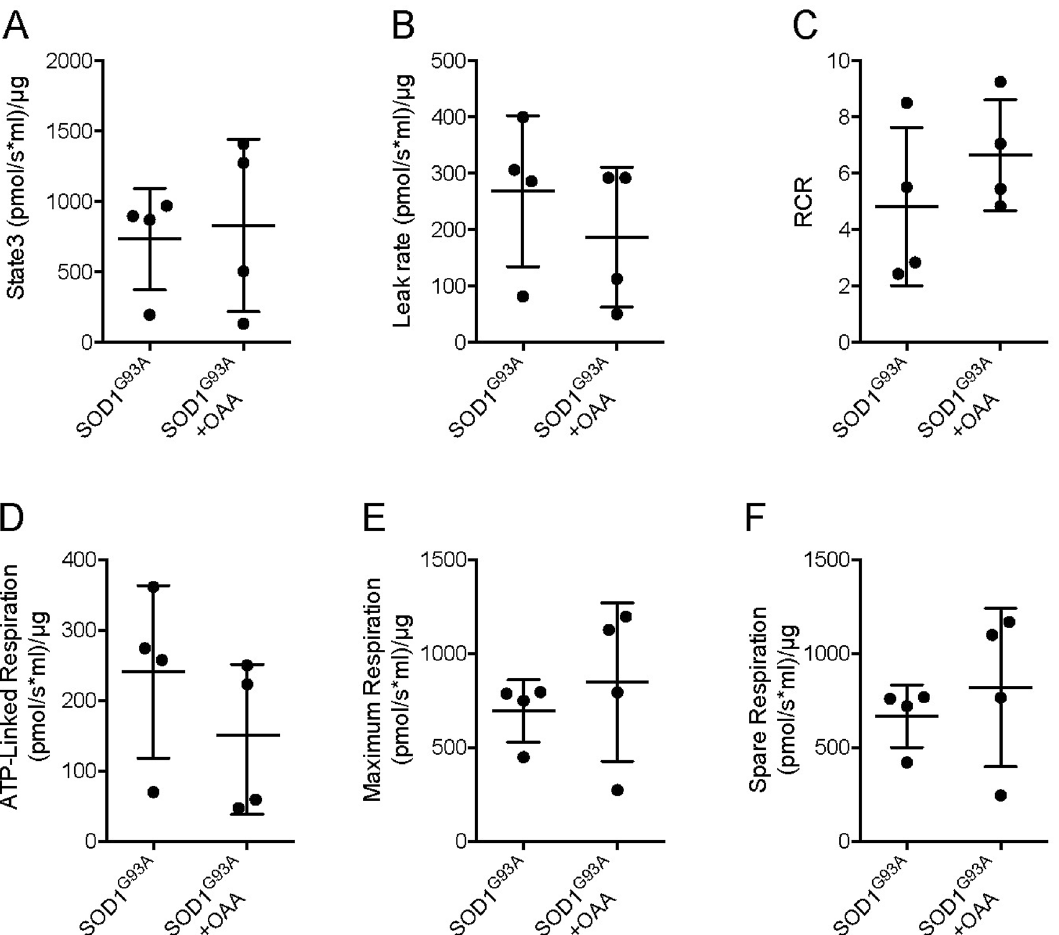
Figure 5. Mitochondrial respiratory function in brain homogenates of SOD1 G93A mice with or without oxaloacetate (OAA) treatment. ( A ) The respiration rate obtained after addition of ADP. ( B ) The leak respiration rate after oligomycin injection. ( C ) Respiratory control ratio (RCR) obtained by dividing the state 3 by the leak rate. Respiration rate for ( D ) ATP-linked component, ( E ) maximum component, and ( F ) spare component. The graphs show data from four mice with whiskers showing mean ± S.D. There were no statistically significant differences with or without oxaloacetate treatment ( n = 4, mean ± S.D. and unpaired t test p values were ( A ) SOD1 G93A , 732.9 ± 360.1, SOD1 G93A + OAA, 829.4 ± 611.6, p = 0.7947; ( B ) SOD1 G93A , 268.2 ± 133.8, SOD1 G93A + OAA, 186.6 ± 124, p = 0.4056; ( C ) SOD1 G93A , 4.8 ± 2.8, SOD1 G93A + OAA, 6.6 ± 2.0, p = 0.3282; ( D ) SOD1 G93A , 240.9 ± 122.7, SOD1 G93A + OAA, 145.1 ± 106.4, p = 0.2825; ( E ) SOD1 G93A , 695.3 ± 165.6, SOD1 G93A + OAA, 848 ± 421.2, p = 0.5251; and (F) SOD1 G93A , 667.1 ± 165.6, SOD1 G93A + OAA, 819.8 ± 421.2, p =